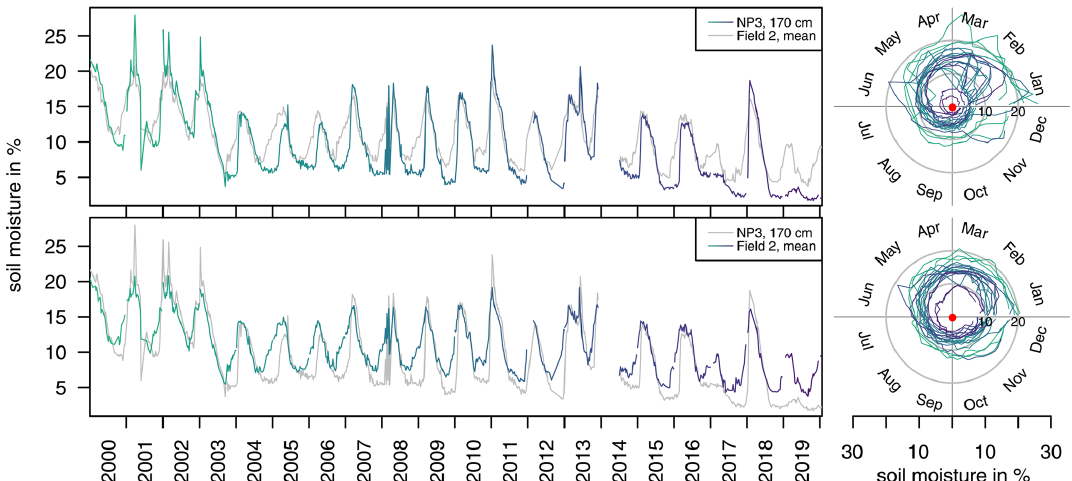
Figure 7. Time series of soil moisture at NP3 at 170cm and mean soil moisture of Field 2 as well as the same data in a polar coordinate system to highlight seasonal asymmetry of gradual drying and fast re-wetting as well as the overall trend of declining soil moisture. Colors indicate the year of the measurement. For context, gray lines showing mean soil moisture of Field 2 and soil moisture at NP3 at 170cm, respectively, were added.